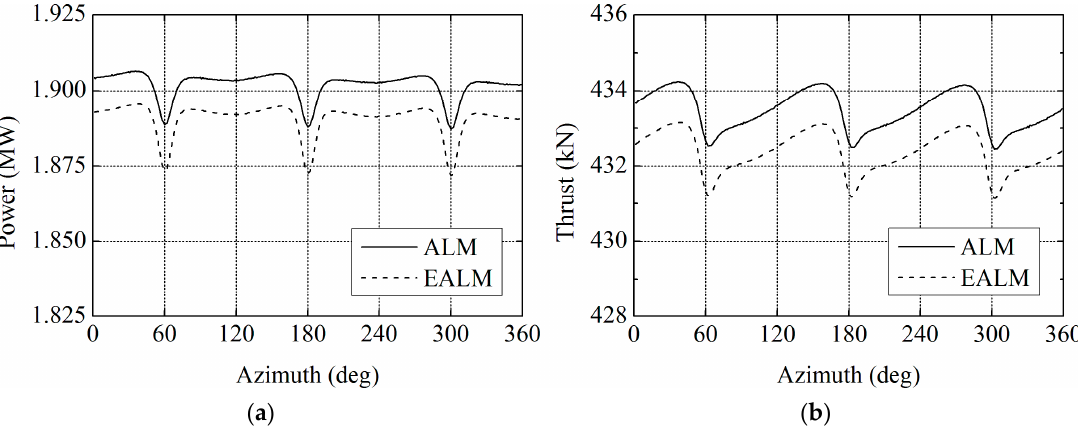
Figure 17. Comparisons of the aerodynamic performance results between traditional actuator line